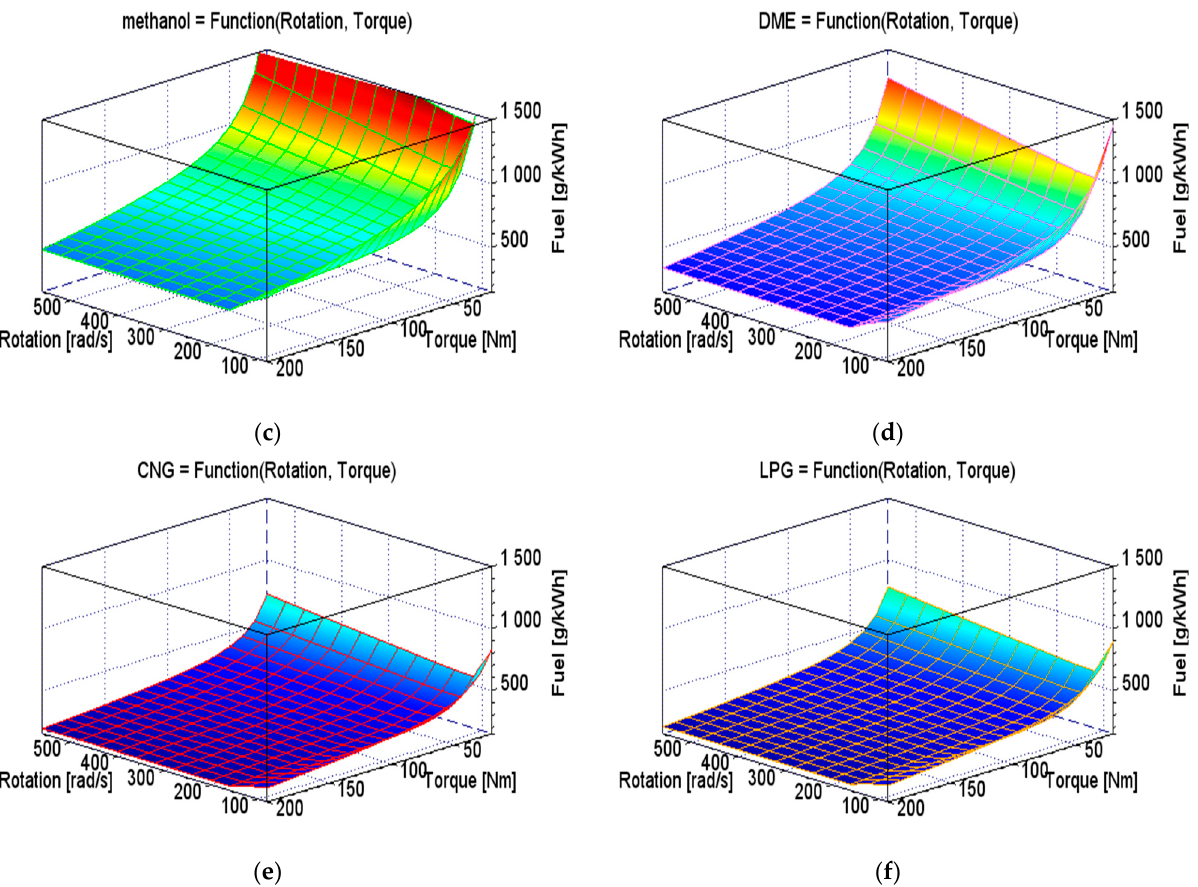
Figure 4. A model of individual fuel consumption characteristics built with the use of a neural network and used in further simulations: ( a ) petrol 95; ( b ) ethanol; ( c ) methanol; ( d ) DME; ( e ) CNG; ( f ) LPG.